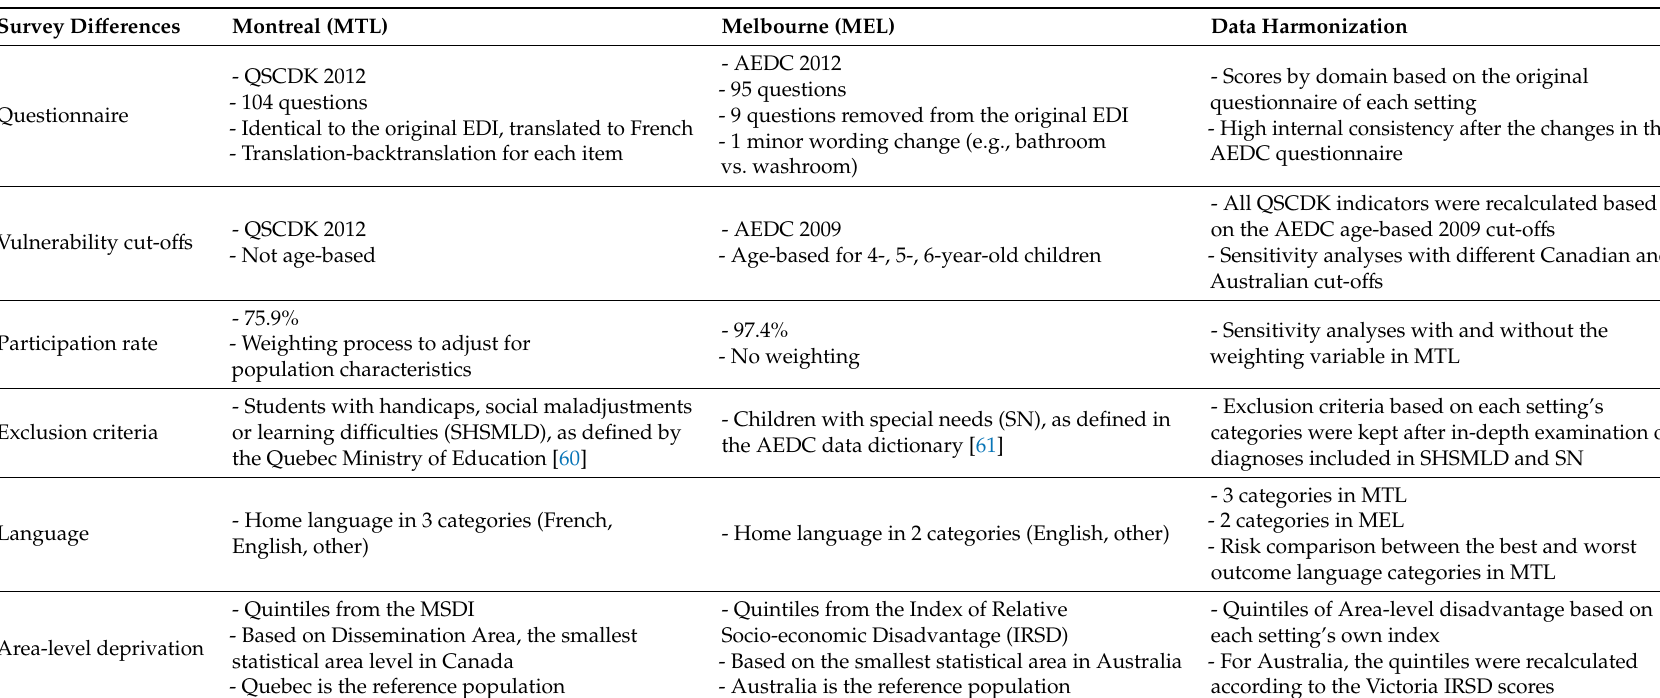
Table 2. Data harmonization to account for survey methodological di ff